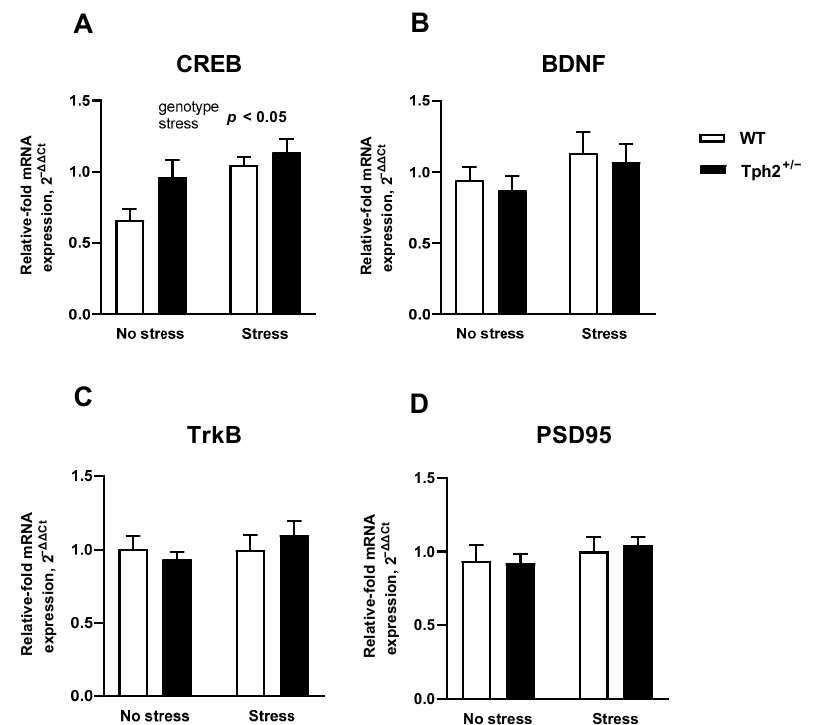
Figure A2. Expression of Creb , Bdnf , Trkb and PSD95 in the prefrontal cortex of Tph2 +/ − mice. ( A ) Creb expression was significantly higher in the stressed animals, independent of genotype (WT NS n = 6, WT S n = 9, Tph2 +/ − NS n = 6, Tph2 +/ − S n = 6). ( B ) No significant differences were found for Bdnf expression (WT NS n = 6, WT S n = 9, Tph2 +/ − NS n = 6, Tph2 +/ − S n = 7), ( C ) Trkb expression (WT NS n = 6, WT S n = 9, Tph2 +/ − NS n = 6, Tph2 +/ − S n = 7), or for ( D ) PSD95 expression (WT NS n = 6, WT S n = 9, Tph2 +/ − NS n = 6, Tph2 +/ − S n = 7). WT, wild type.